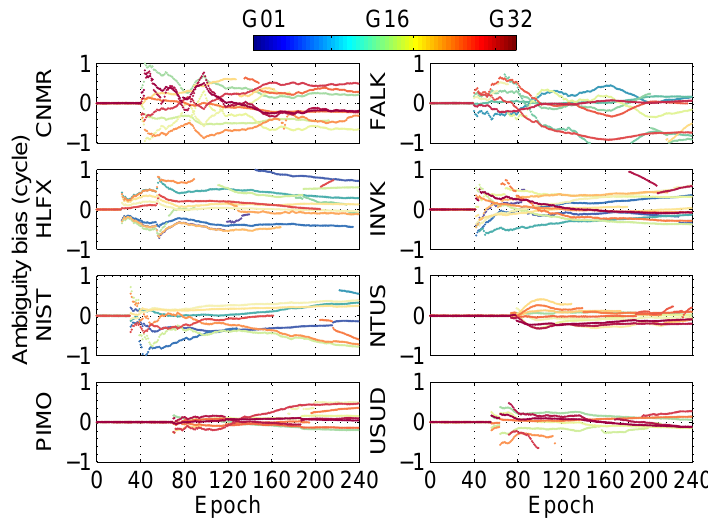
Figure 11. Ambiguity bias at different stations in the post-processing